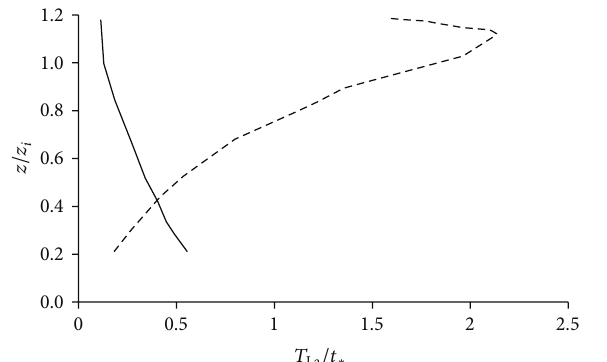
Figure 11: 1/𝑒 Lagrangian time scale of the updraughts (full curve) and downdraughts (broken curve) as a function of the nondimensional height.